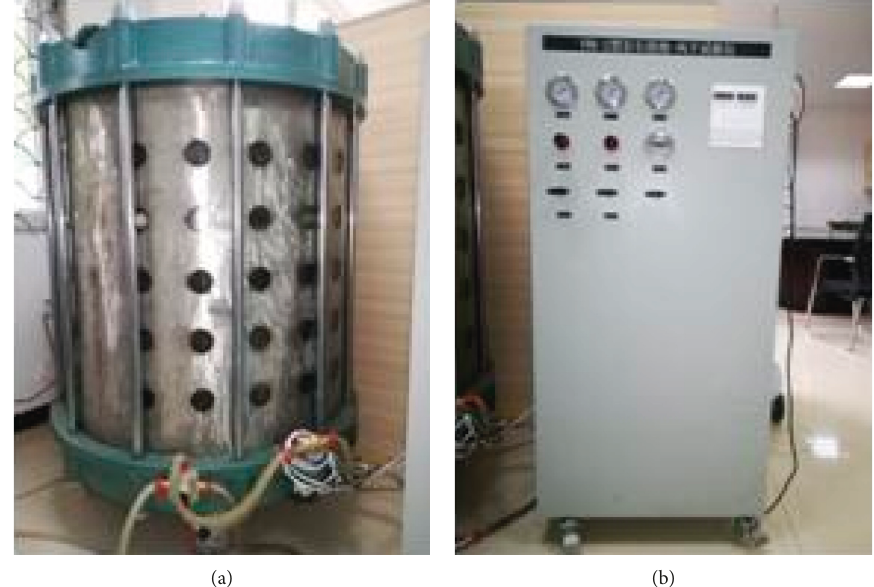
Figure 3: YRK-2 rock soaking-air drying test device. (a) Soaking container. (b) Control